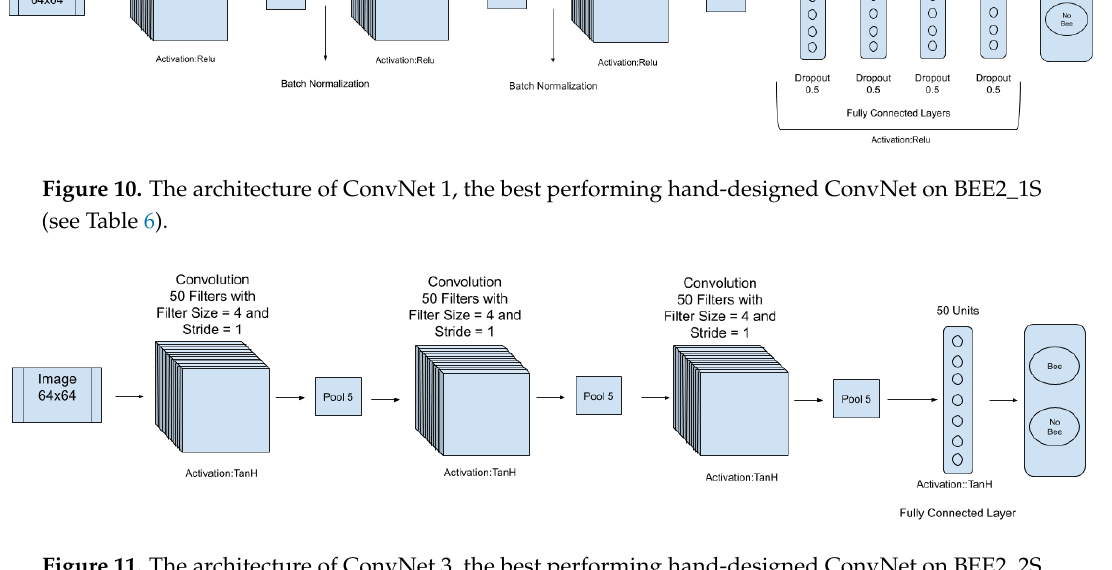
Figure 11. The architecture of ConvNet 3, the best performing hand-designed ConvNet on BEE2_2S (see Table